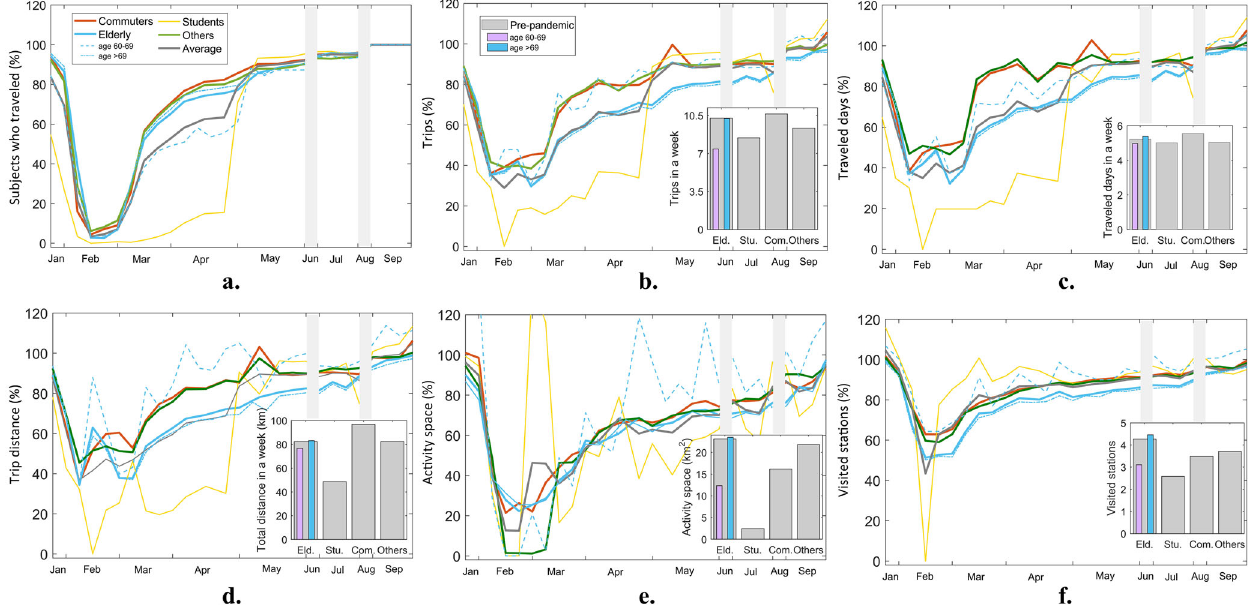
Fig. 3 Mobility indicators by groups in 2020. a subjects who traveled during the pandemic, b trips, c traveled days, d total trip distance, e activity space, and f visited stations. All indicators are reported by weeks and compared to the pre-pandemic mobility level (i.e., weekly average in November 2019). Note that bar plotting represents the pre-pandemic mobility level.